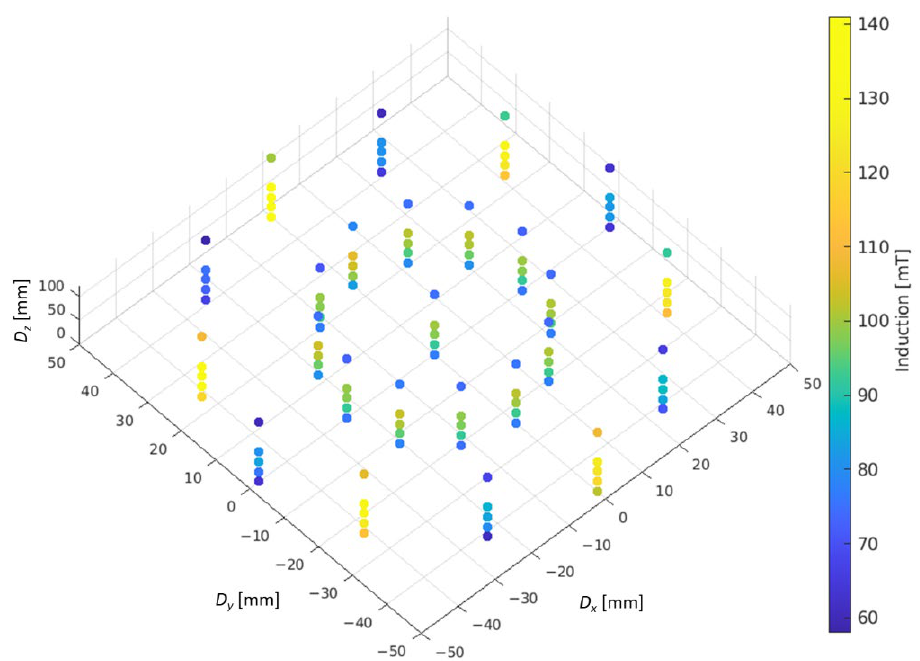
Figure 5. Distribution of the measured value of the magnetic induction inside the mill’s working chamber. Dx and Dy are the distance in mm from the center of the working chamber, while Dz is the distance from the bottom (beginning) of the working chamber. The value of the induction in mT is marked with the appropriate color, shown in the legend.